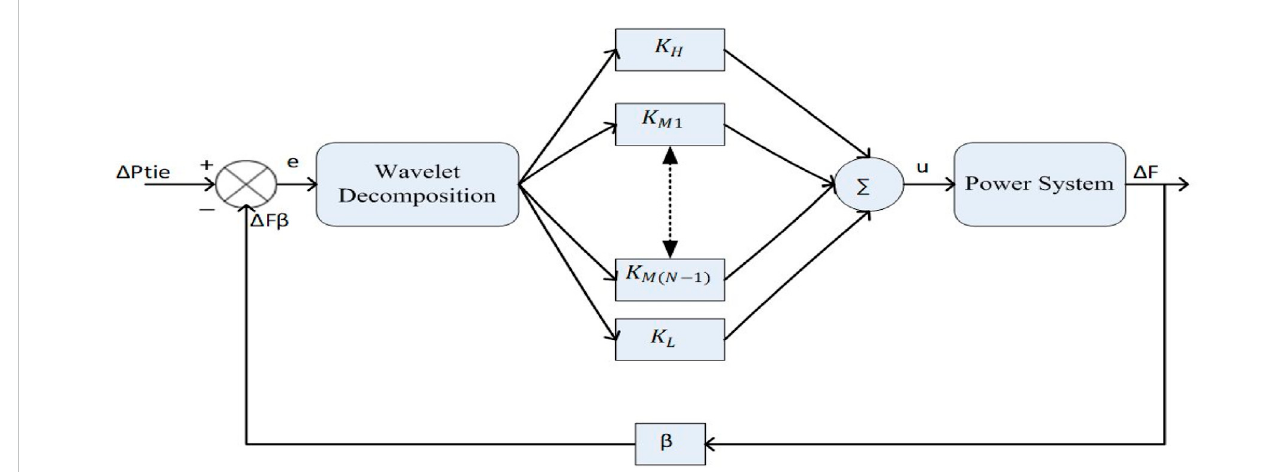
FIGURE 5 Schematic Diagram of MRPID controller with power system.